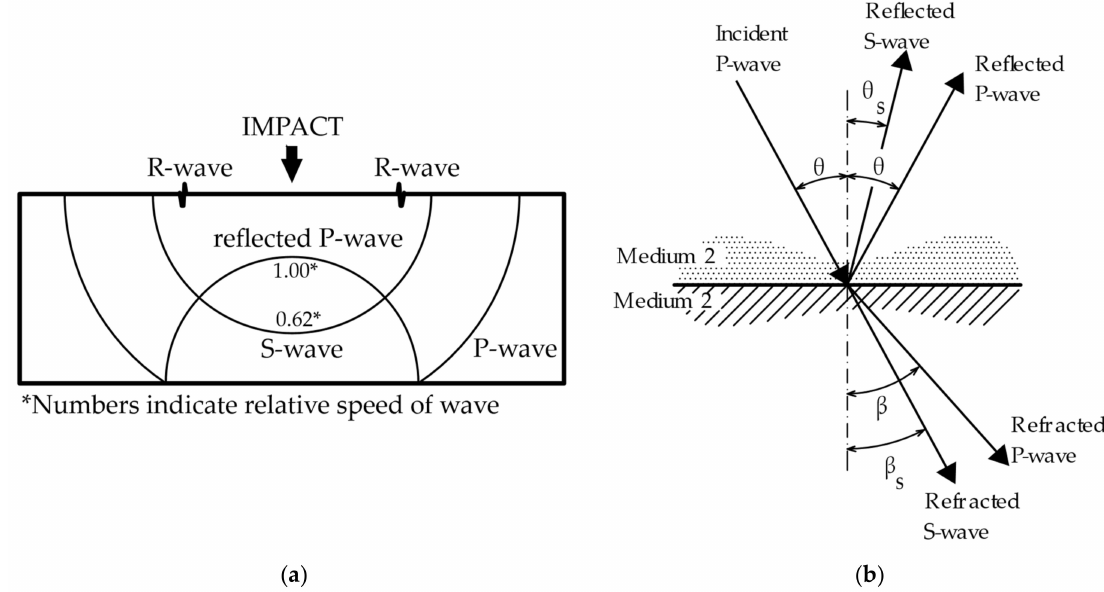
Figure 1. Wave theory: ( a ) Differentiation of waves during signal generation [26]; ( b ) reflection and refraction of waves at the interface of two different materials